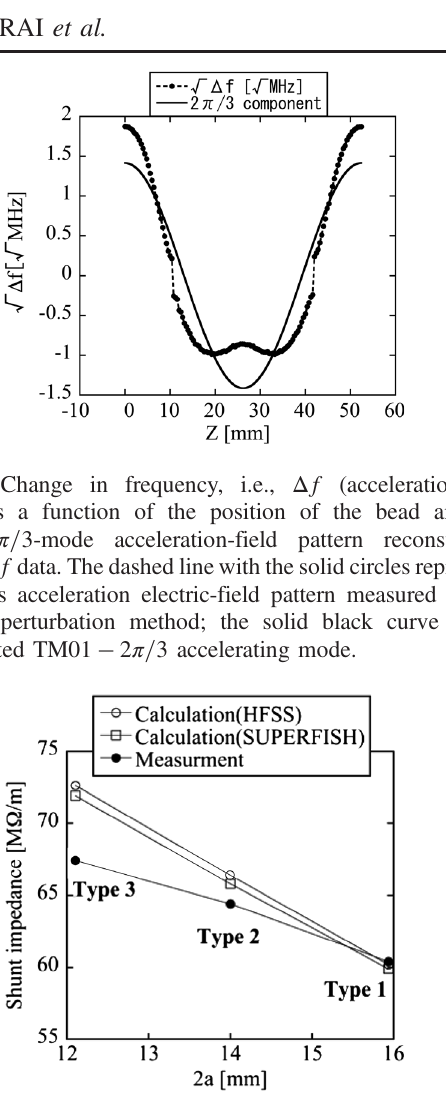
FIG. 7. Shunt impedances along the accelerating cells of the three test cavities. The solid circles denote the measurement results. The open circles and open squares denote the calculated results obtained by HFSS [24] and SUPERFISH [27], respectively. ( Δ f ) as a function of the position of the bead moved along the center axis of the cavity. The Δ f curve corresponds to an electric-field pattern including the fundamental mode and its space harmonics. Fourier analysis reconstructs the